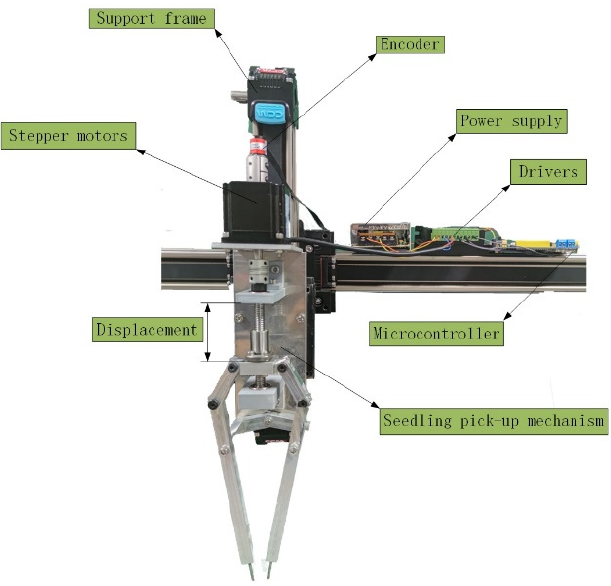
Figure 9. Positioning control test stand. Table 4. Positioning control test